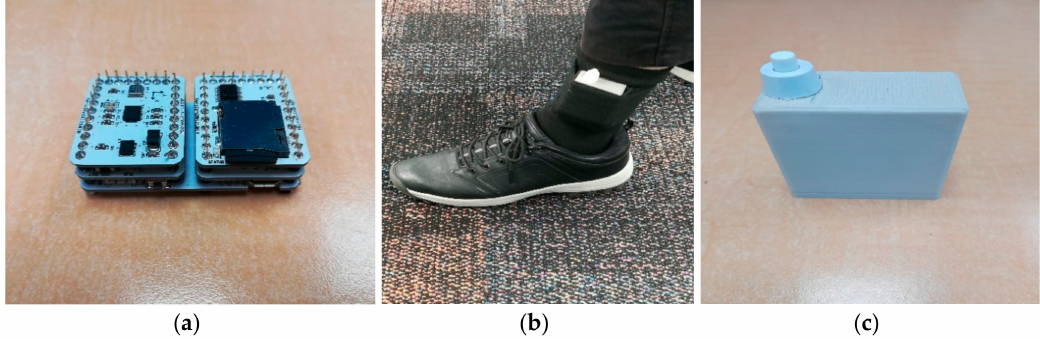
Figure 2. ( a ) 3D accelerometer sensor, along with the SD board and microcontroller. ( b ) 3D sensor on the ankle of the participant. ( c ) 3D sensor